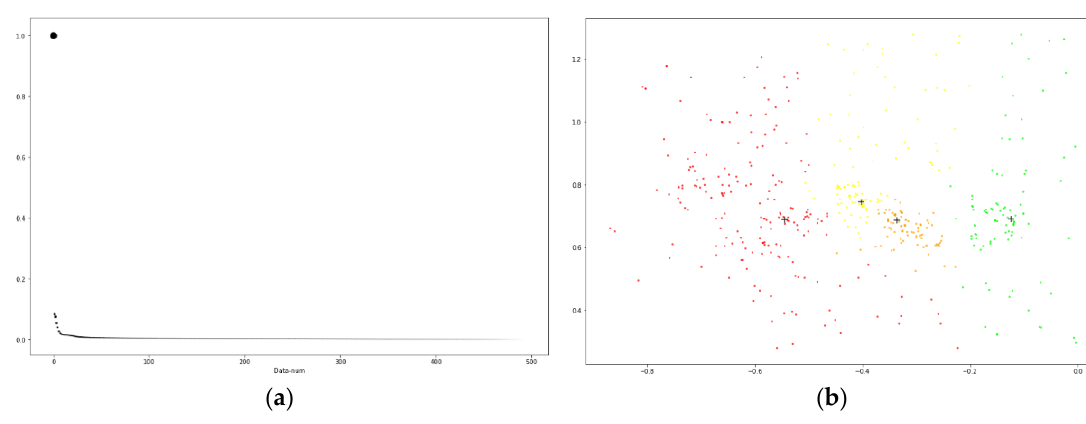
Figure 2. Cluster center selection diagram. ( a ) is the descending arrangement diagram of γ i ; ( b ) is the display of the cluster center point selected by the graph ( a ) in the data sample.